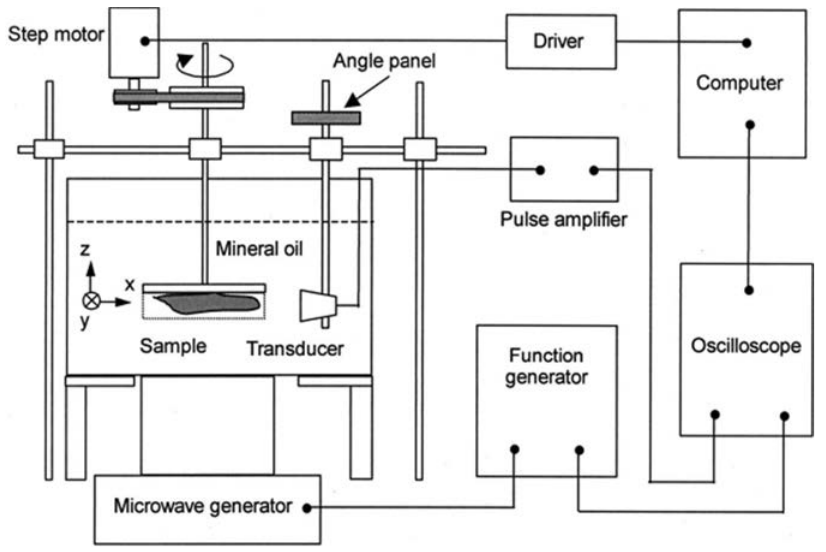
Fig. 9. Schematic diagram of single-element TAI system. 8